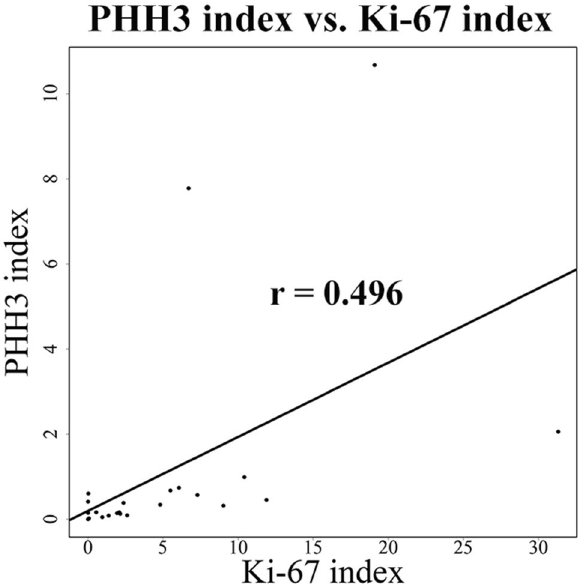
Figure 4. Correlation analysis between PHH3 index and Ki-67 index. Weak positive correlation is indicated.